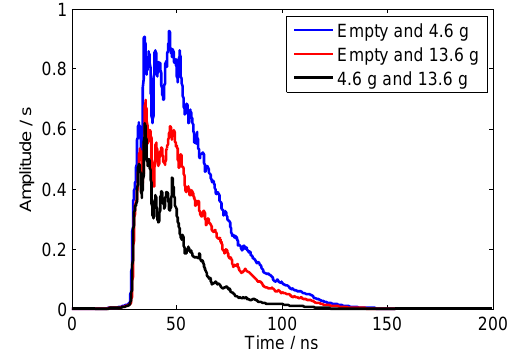
Figure 6. Convolution of the envelopes of the time-domain re- sponses (Fig.